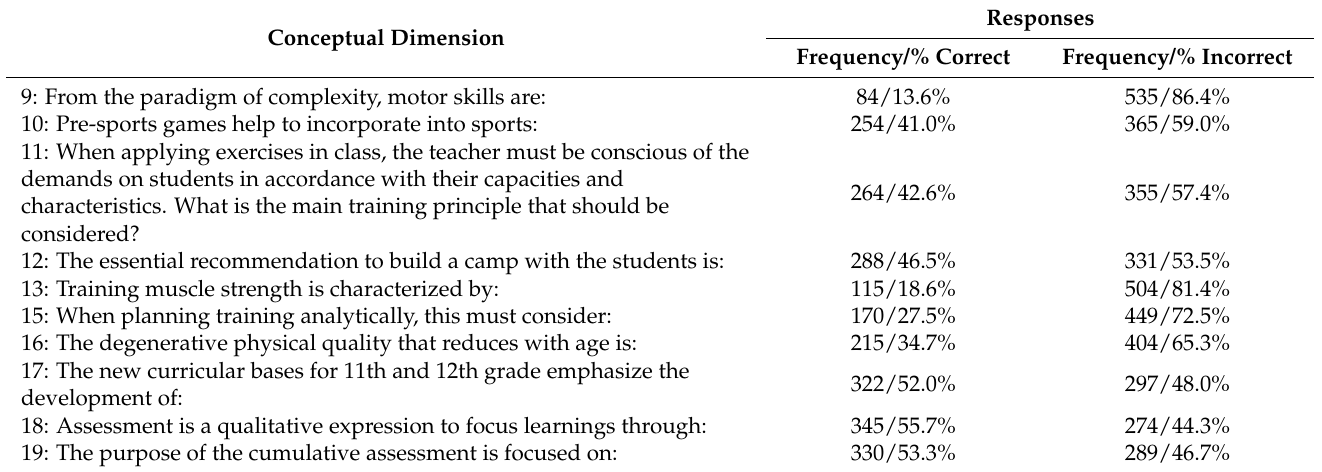
Table 3. Descriptive results for the conceptual